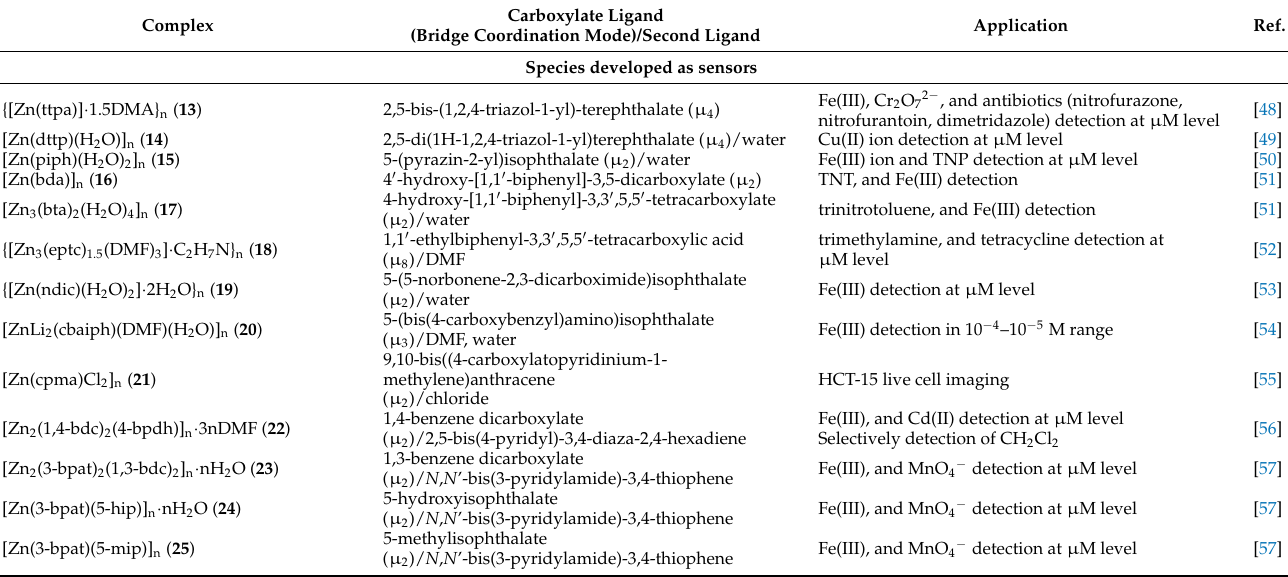
Table 1. Examples of Zn(II) carboxylate-based coordination polymers with diverse applications.